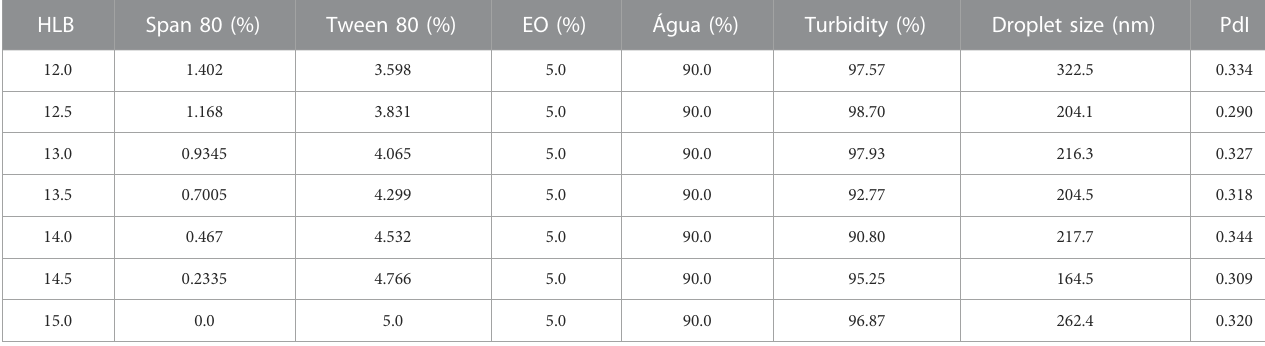
TABLE 2 Composition of formulations with Neomitranthes obscura essential